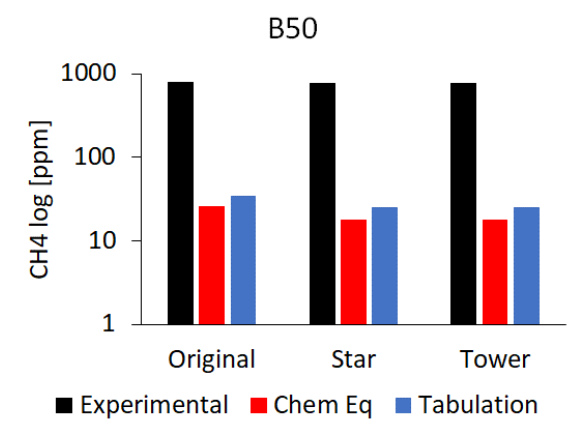
Figure 22. Comparison between the computed and experimental CH 4 emissions for the B50 operating condition on a logarithmic